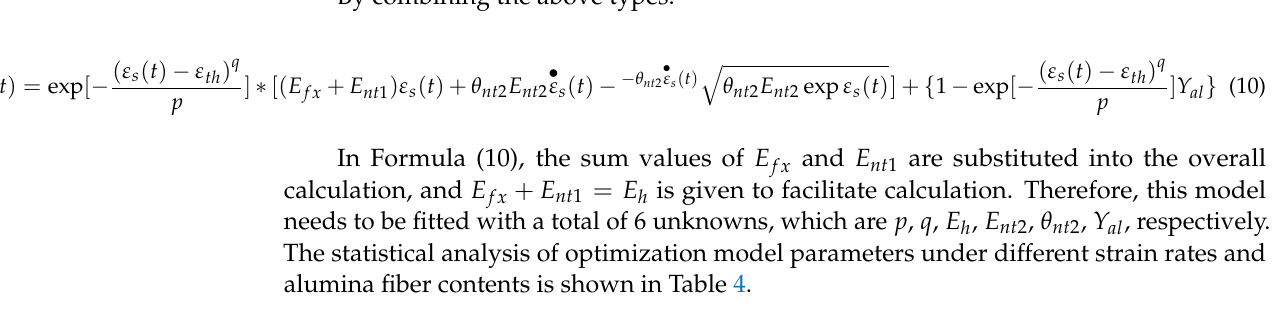
Table 4. Fitting results of impact compression